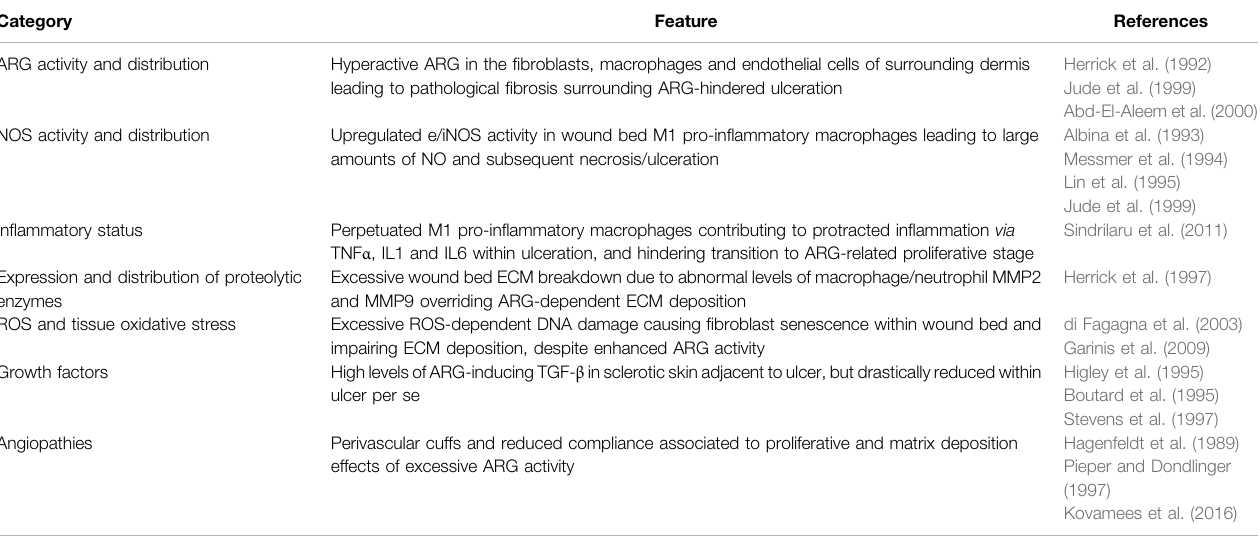
TABLE 1 | Summary ofkey ARG pathway-related pathological commonalities between DFUs and VLUs. Although NOS and ARG are known to have competitive enzymatic activities when expressed within the same cell, they both contribute to DFUs and VLUs, as they show discrete wound expression sites. iNOS is mainly present in endothelial cells and macrophages present at the ulcer base, contributing to defective matrix deposition and necrosis via excessive NO. ARG is mainly expressed in the dermal fi broblasts of the skin surrounding the ulcer itself. The increased ARG activity of both ulcer types is associated with fi brosis surrounding the ulcerations, resulting